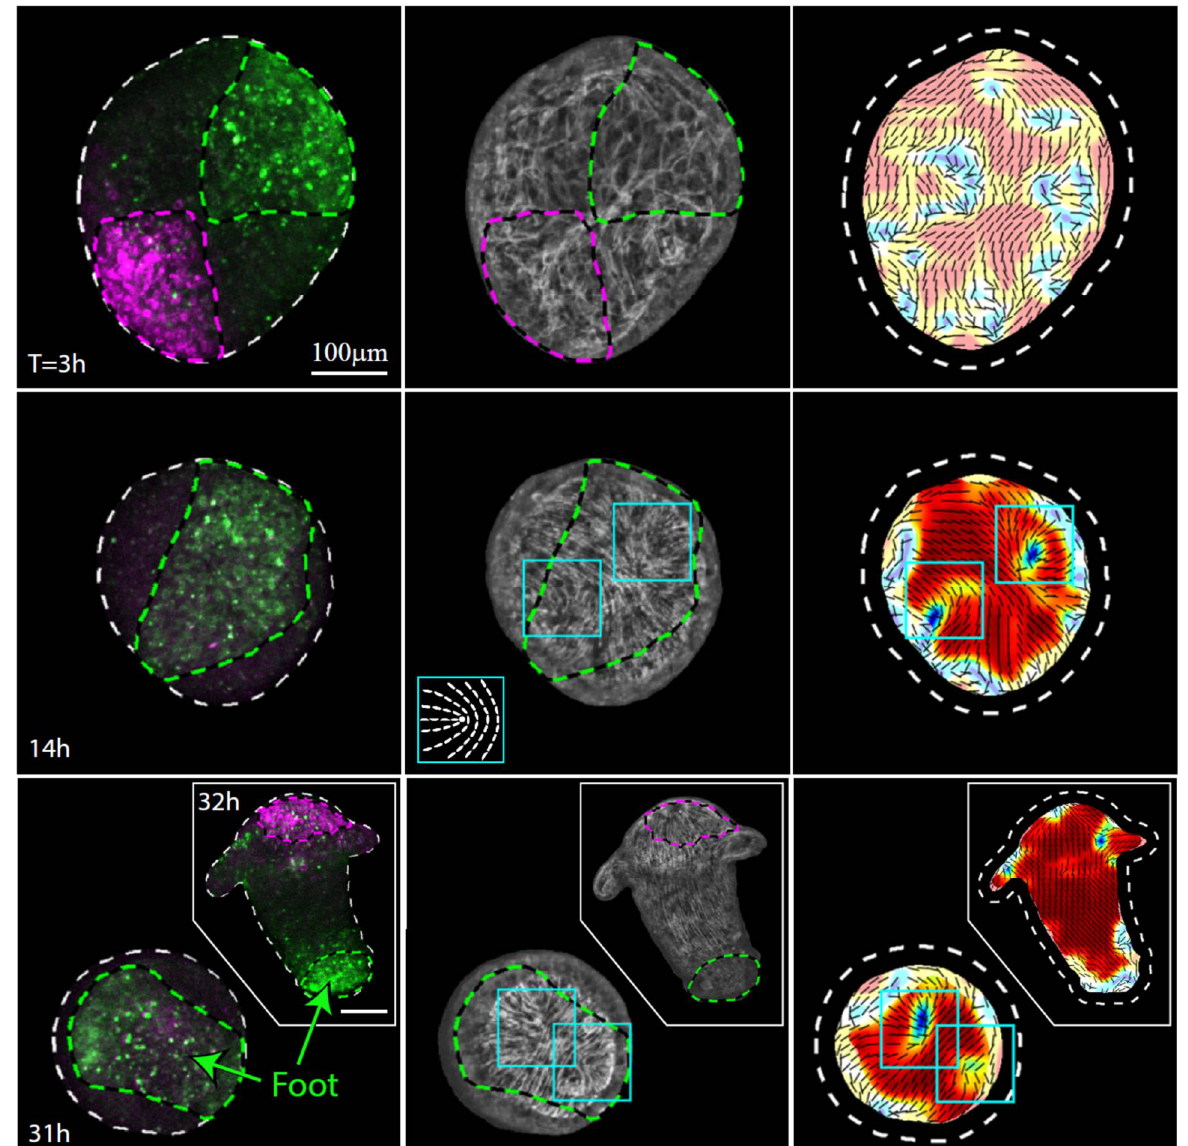
Figure 4. Actin fiber reorganization in the foot region of a regenerating tissue strip. Images from a time-lapse movie (Movie S5) depicting the tissue dynamics and cytoskeletal organization in a regenerating tissue strip expressing lifeact-GFP in the ectoderm (gray) and differentially labeled at its head-facing side with uncaged Abberior CAGE 552 (magenta) and its foot-facing side with uncaged Abberior CAGE 635 (green). For each time point, images depicting an overlay of projected spinning disk confocal images of the fluorescent markers labeling the head-facing side of the strip (magenta) and the foot-facing side of the strip (green) are shown (left), together with an image of the supracellular ectodermal actin fibers on the basal surface (lifeact-GFP, gray) overlaid with contours depicting the labeled regions (middle) and a map of the corresponding actin fiber orientation (black lines) and local order parameter (color shading; see Methods [19]), with the tissue outline indicated by a dashed line. The images at 14 hours (middle row) and 31 hours (bottom row) depict the tissue from a viewpoint showing the region that becomes the foot of the regenerated animal. The locations of the two horseshoe-like defects in the organization of the supracellular actin fibers, which will merge at the foot of the regenerated animal, are denoted by cyan boxes. Inset: schematics showing the actin fiber organization in a horseshoe-like (+1/2) defect. The images at 32 hours (bottom row, inset) show a rotated view of the regenerated animal, in which both the foot region and the head region are visible.